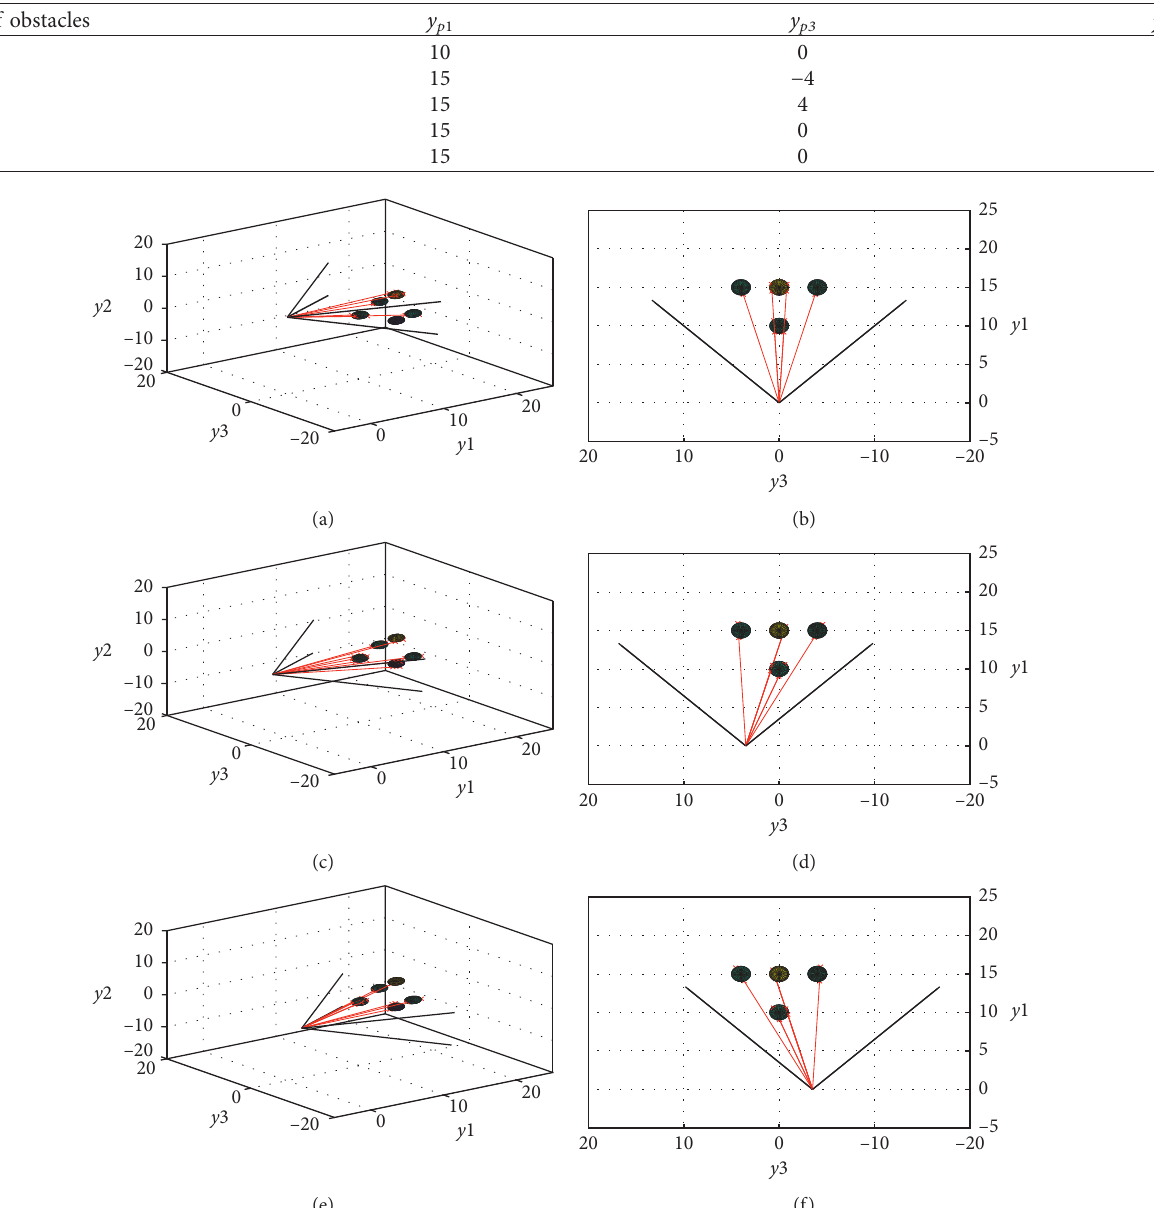
Figure 29: Initial positions of the obstacles and the group of AMR: (a) 3D view; (b) plan view. Table 1: Obstacle coordinates.